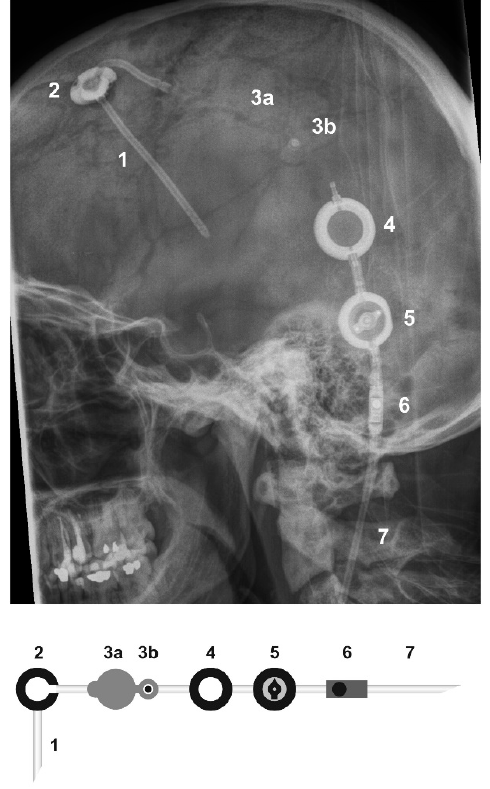
Figure 4. Radiography immediately after shunt implantation in patient 1 and scheme depicting the arrangement of the shunt components. 1 = proximal ventricular catheter; 2 = Rickham reservoir; 3a = on-off valve; 3b = button of the on-off valve; 4 = control reservoir; 5 = programmable differential pressure unit; 6 = gravitational unit; 7 = distal peritoneal catheter.